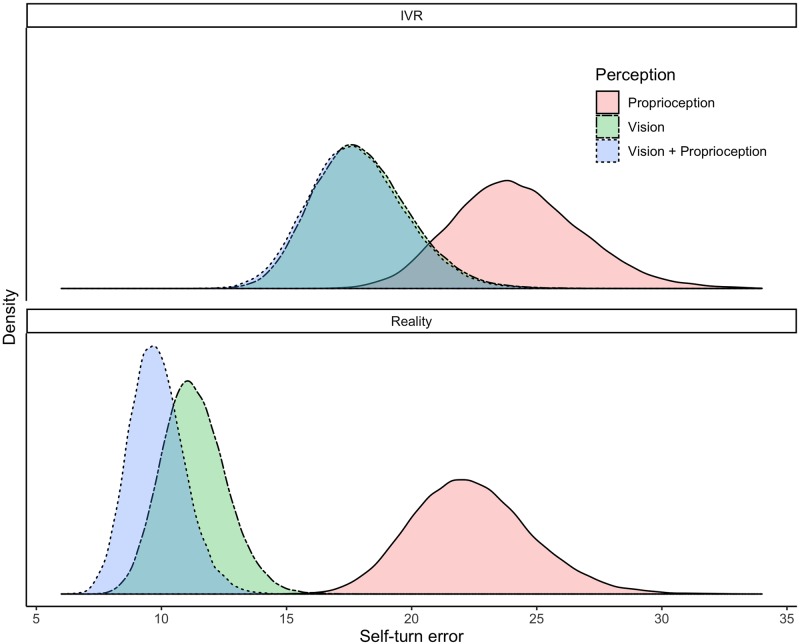
Distributions of the predicted means of self-turn error according to the different conditions.(nparticipants = 49; nobservations = 578).